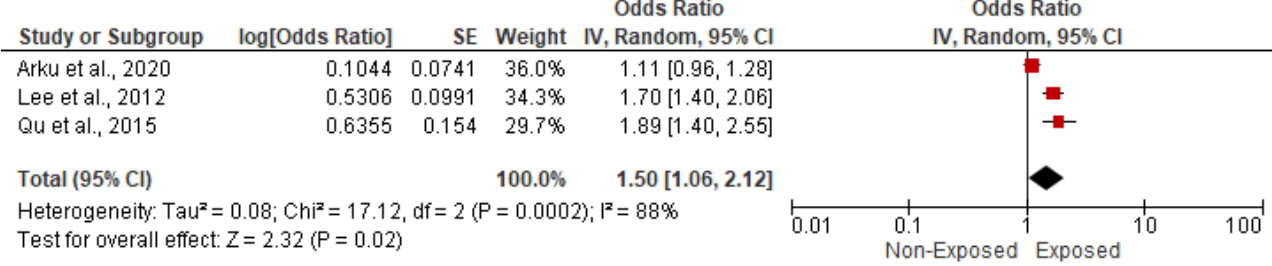
Figure 13. Forest plot of summary analysis of the Odds ratio and 95% CI of the association between HAP and hypertension. The size of the red squares is proportional to the statistical weight of each trial. The gray diamond represents the pooled point estimate. The positioning of both diamonds and squares (along with 95% CIs) beyond the vertical line (unit value) suggests a significant outcome (IV = inverse variance).